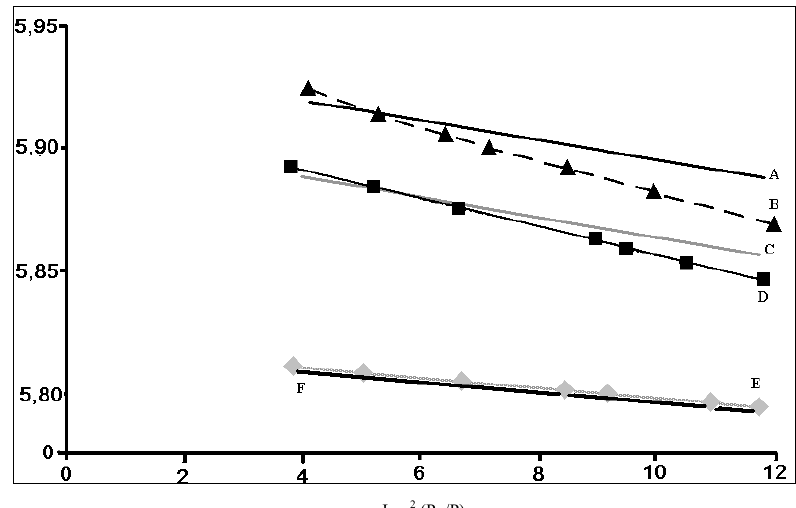
Figure 4. Representation Dubinin-Radushkevich model and comb drives. A) MP32, B) MD32, C) MP48, D) MD48, E) MP20, F)